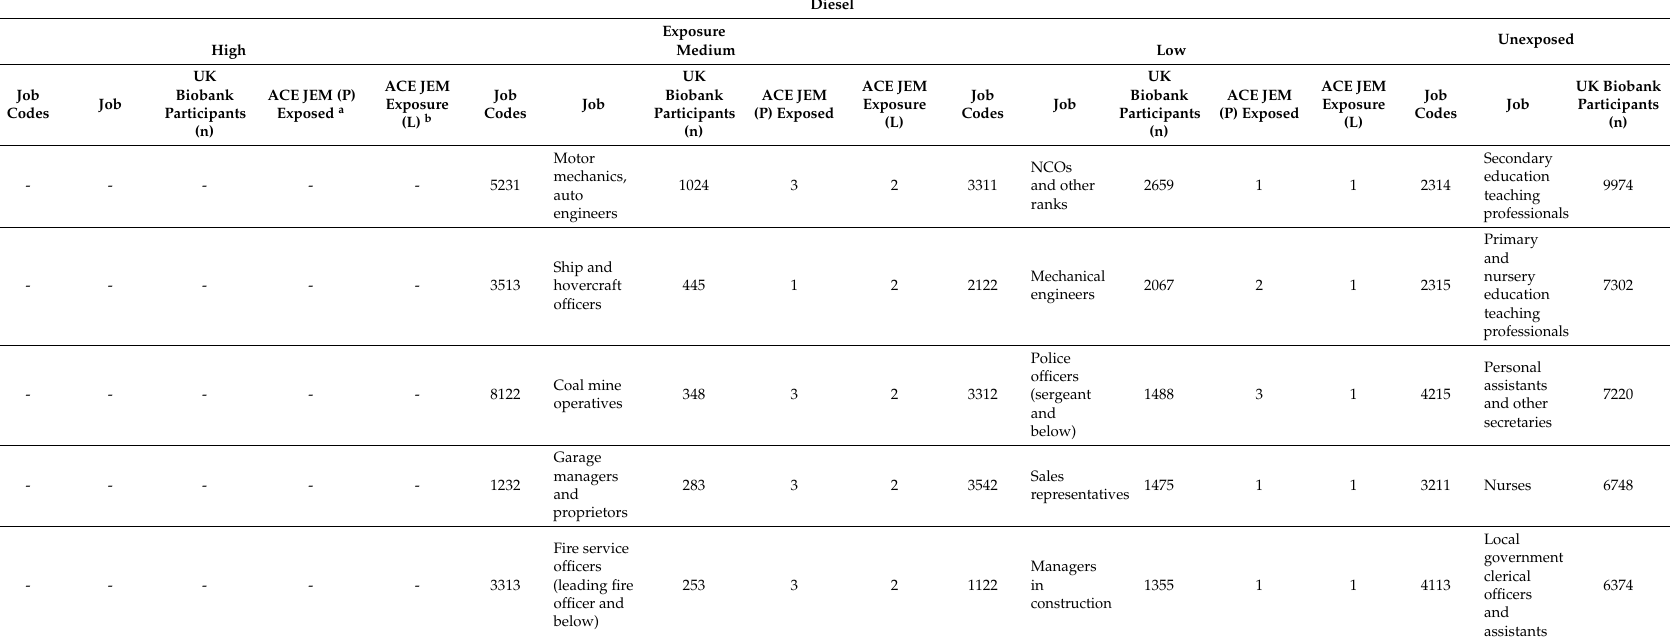
Table 3. The most common occupations in UK Biobank and their level of exposure and the proportion exposed to diesel according to ACE JEM. Diesel Exposure Unexposed High Medium